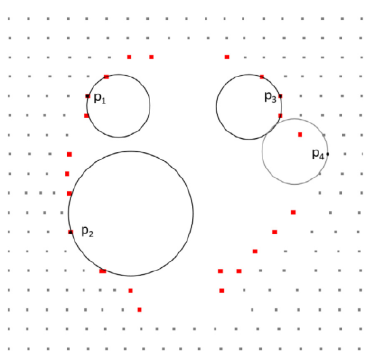
Figure 3 : Boundary Point Detection, three holes create a circle (Tang et al. 2022)